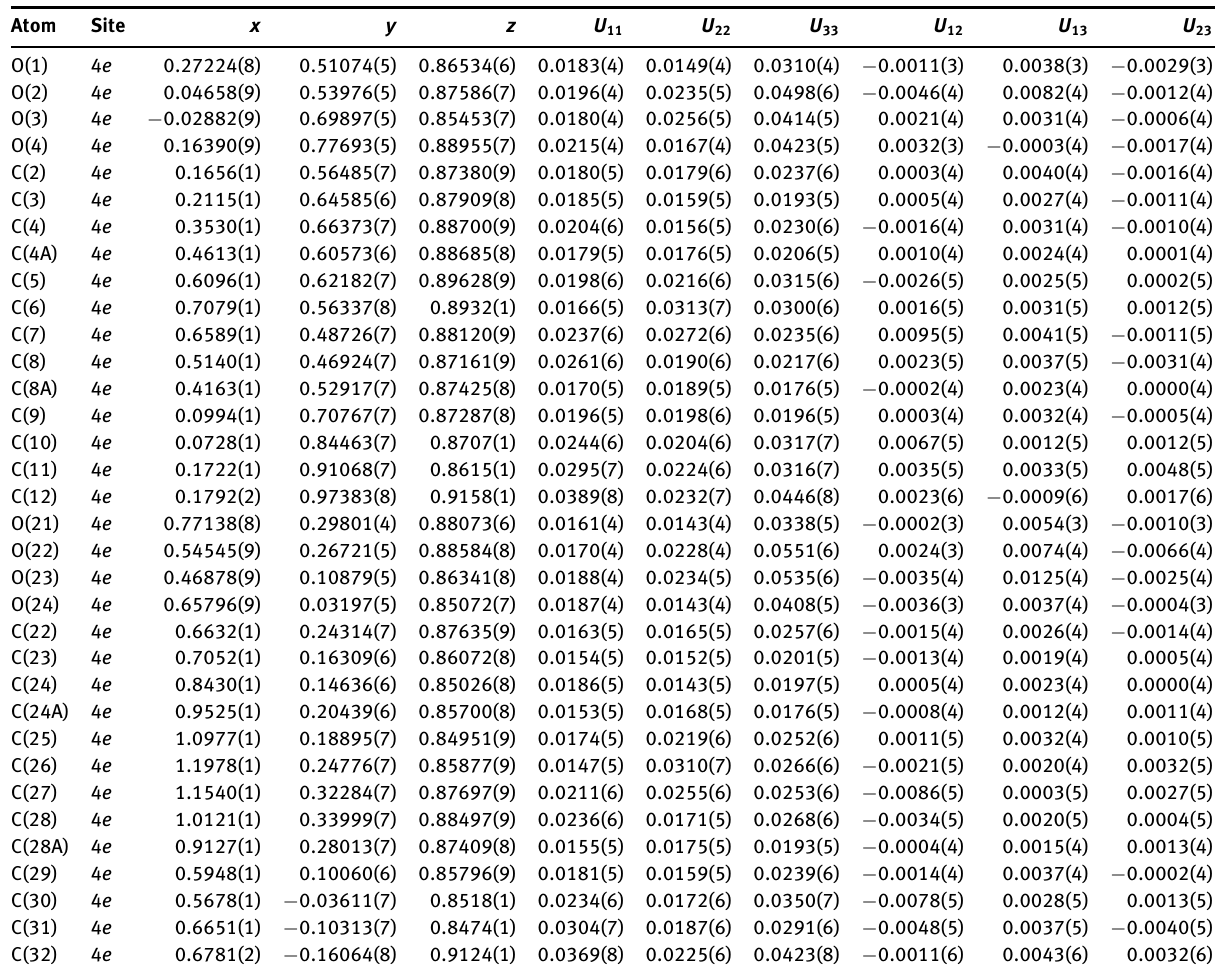
Table 3: Atomic displacement parameters (Å 2